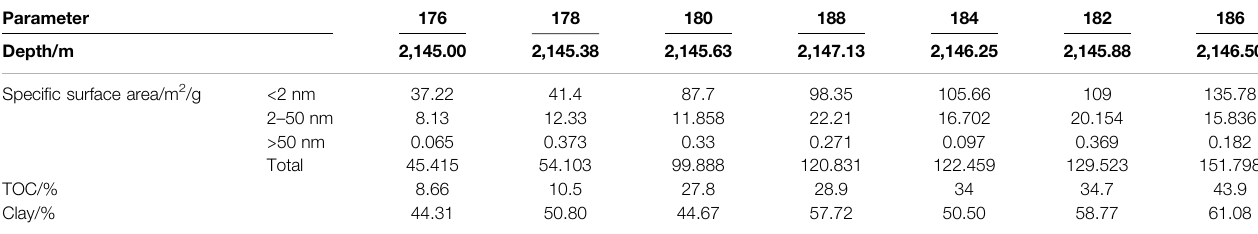
TABLE 2 | TOC content; clay mineral content, and volumes of micropores, mesopores, and macropores of Shan 23 shale.